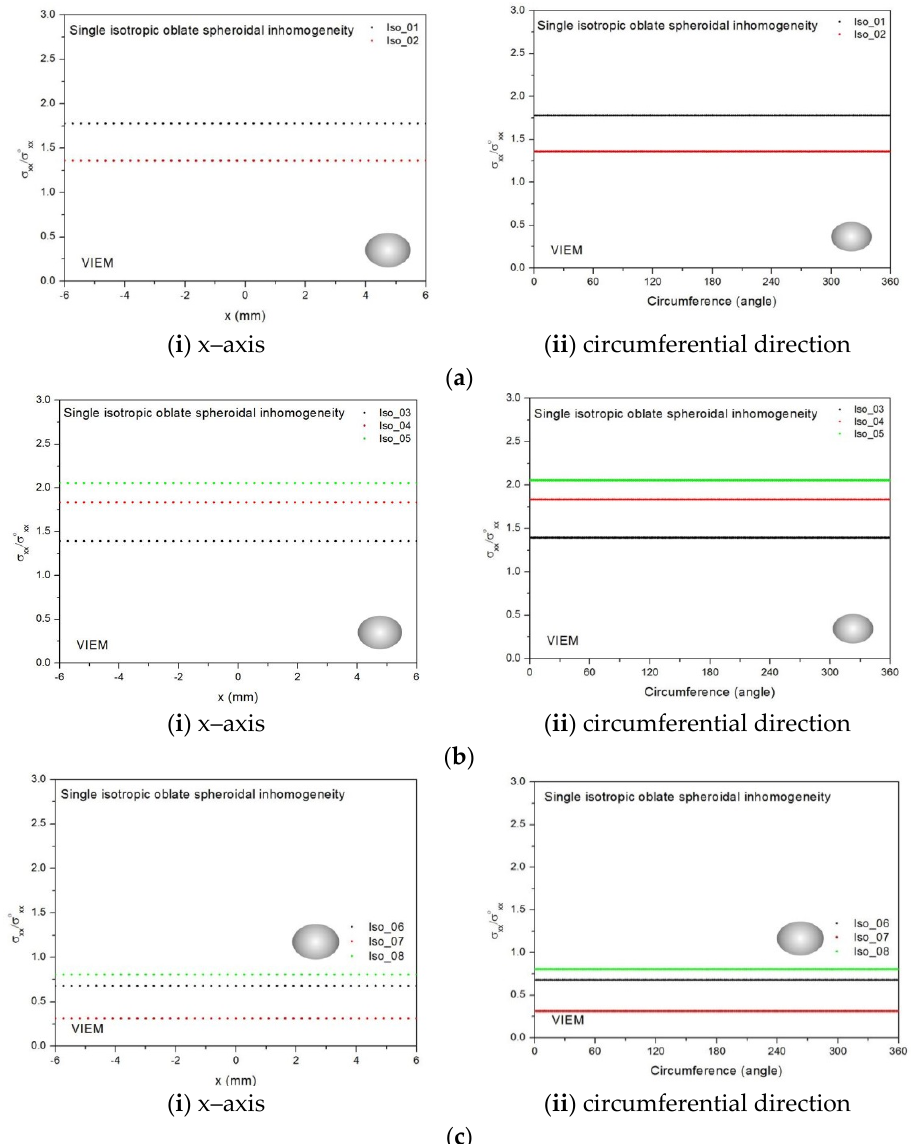
Figure 18. VIEM results for the normalized tensile stress component ( σ xx / σ oxx ) along ( i ) the x–axis inside and ( ii ) the circumferential direction of the isotropic oblate spheroidal inclusions with b/a = c/a = 0.5 (a = 6 mm) under uniform remote tensile loading. ( a ) Iso_01 and Iso_02. ( b ) Iso_03, Iso_04 and Iso_05. ( c ) Iso_06, Iso_07 and Iso_08.